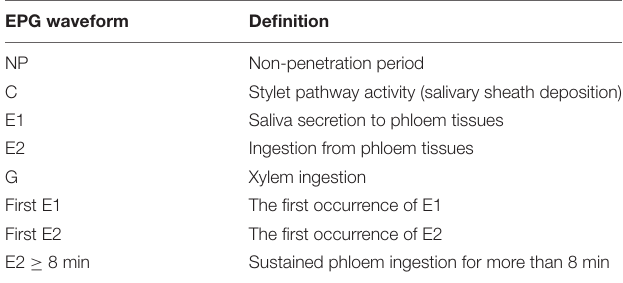
TABLE 1 | The electrical penetration graphs (EPG) of the cotton aphid Aphis gossypii and the respective correlated stylet penetration